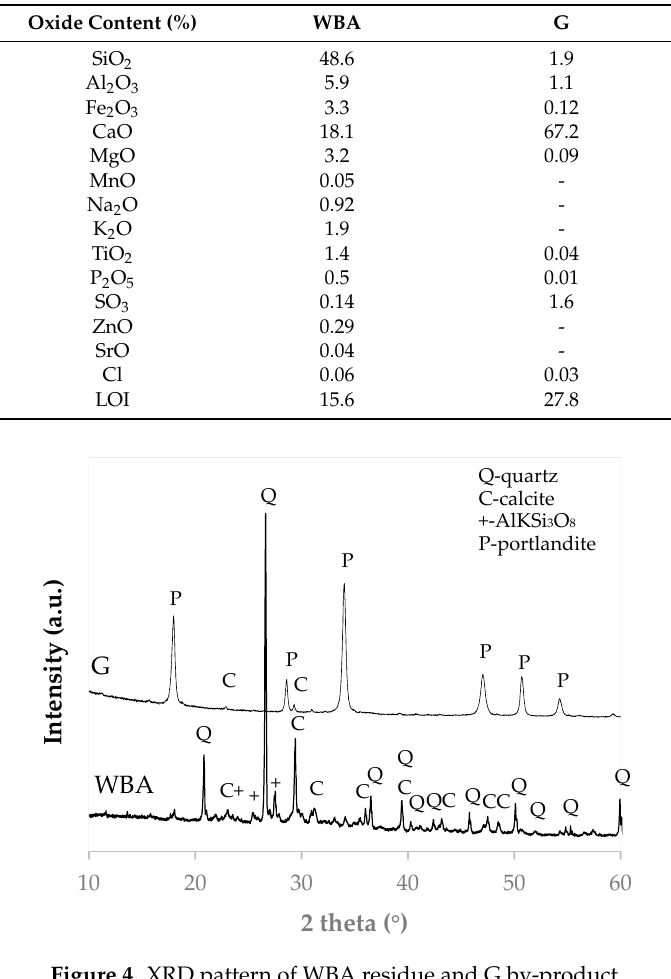
Figure 5. Calcium silicate units. The XRD patterns of the calcium-silicate units (Figure 6), indicate the presence of diffraction peaks corresponding to unreacted raw materials species, such as quartz present in the WBA residue, portlandite present in the G by-product and calcite present in both raw materials. The quartz peak is more intense as increasing quantities of ash were incorporated, while the portlandite peak intensifies as increasing amounts of GeoSilex were incorporated. In addition, small diffraction peaks corresponding to hydrated calcium silicates due to their amorphous character, can be observed. These diffraction peaks are less intense as increasing amounts of GeoSilex (60–80 wt%) were incorporated, which could indicate an excess of calcium oxide and an insufficient amount of silica and alumina present. This fact could lead to a lesser extent of the pozzolanic reaction.